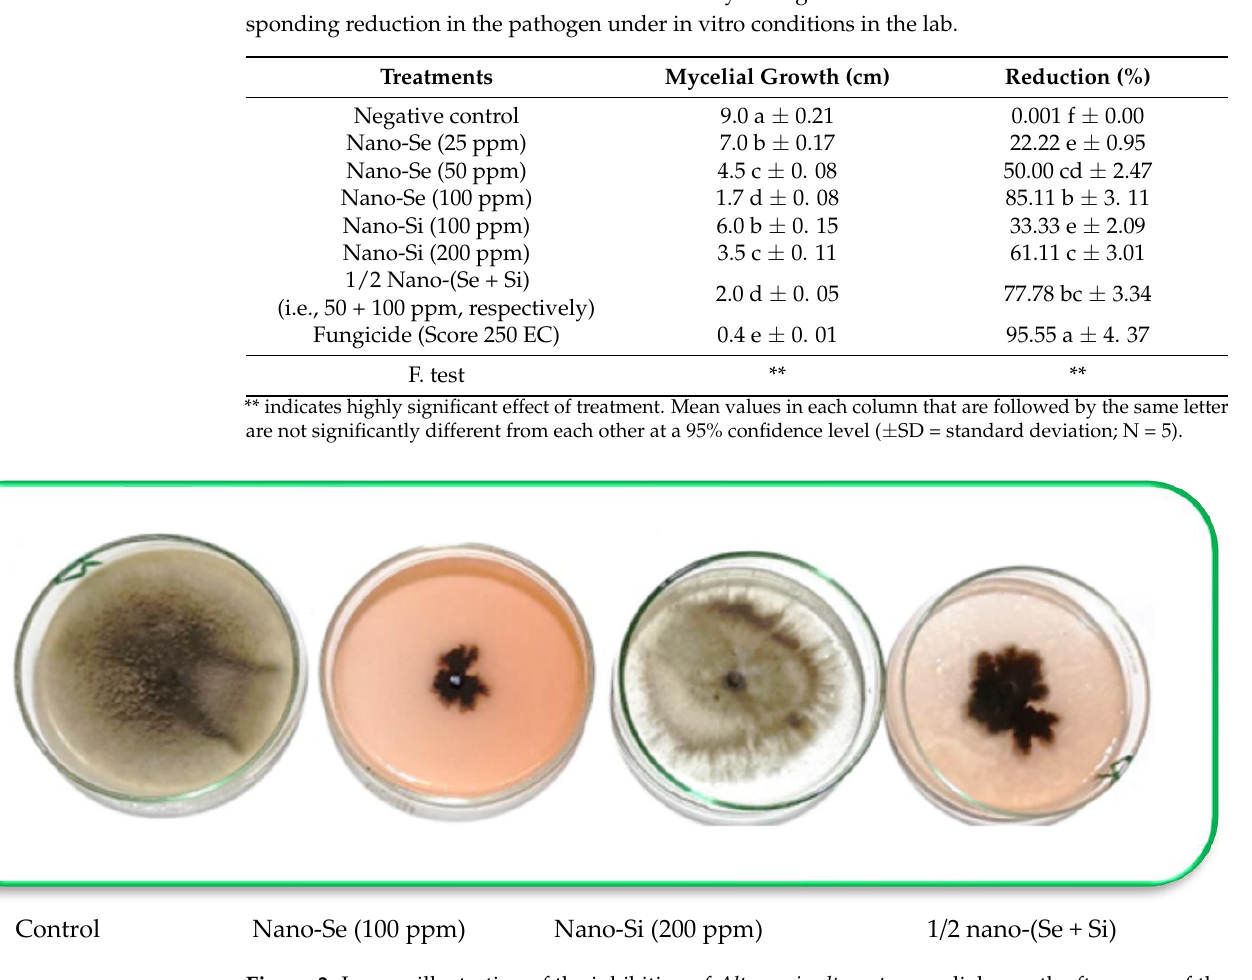
Figure 4. Light microscopic image (200×) of conidia of Alternaria alternata grown on PDA for 7 days after incubation, where ( A ) is influenced by Nano-Se (100 ppm) and ( B ) is the negative control with no treatment.